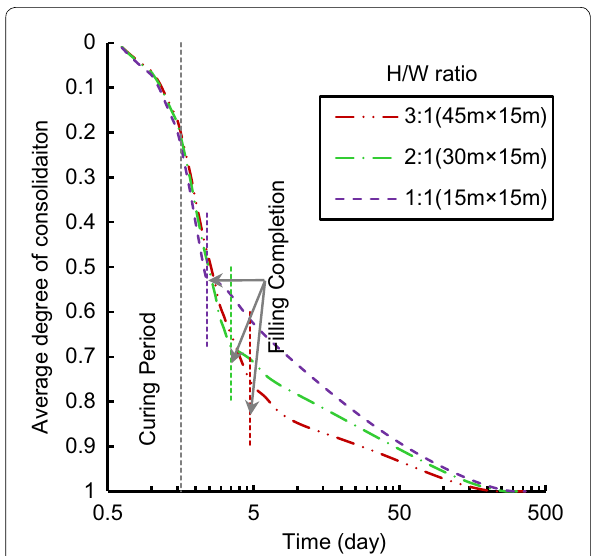
Fig. 13 Effect of H/W ratios on the consolidation process of